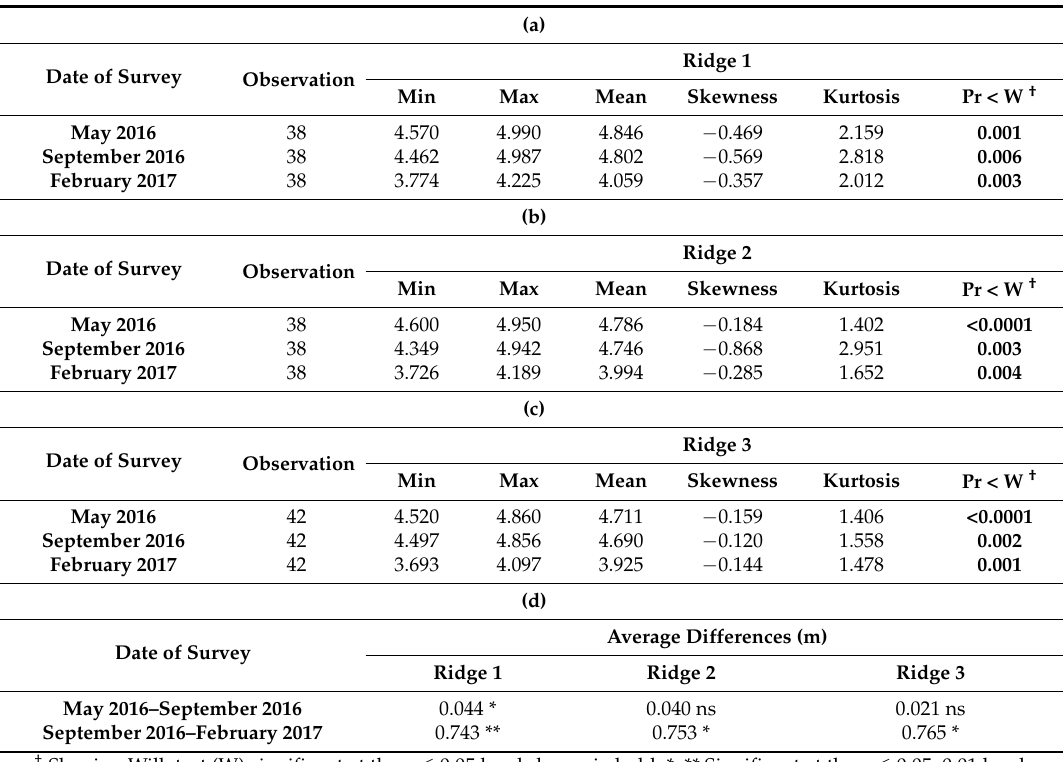
Table 1. Descriptive statistics of elevation (m a.s.l.) for ( a ) the first ridge (intercropping cauliflower crop and burr medic living mulch—LM), ( b ) the second ridge (intercropping cauliflower crop and crimson clover LM) and ( c ) the third ridge (no LM control) in May 2016, September 2016 and February 2017. Results of the Mann-Whitney test ( d